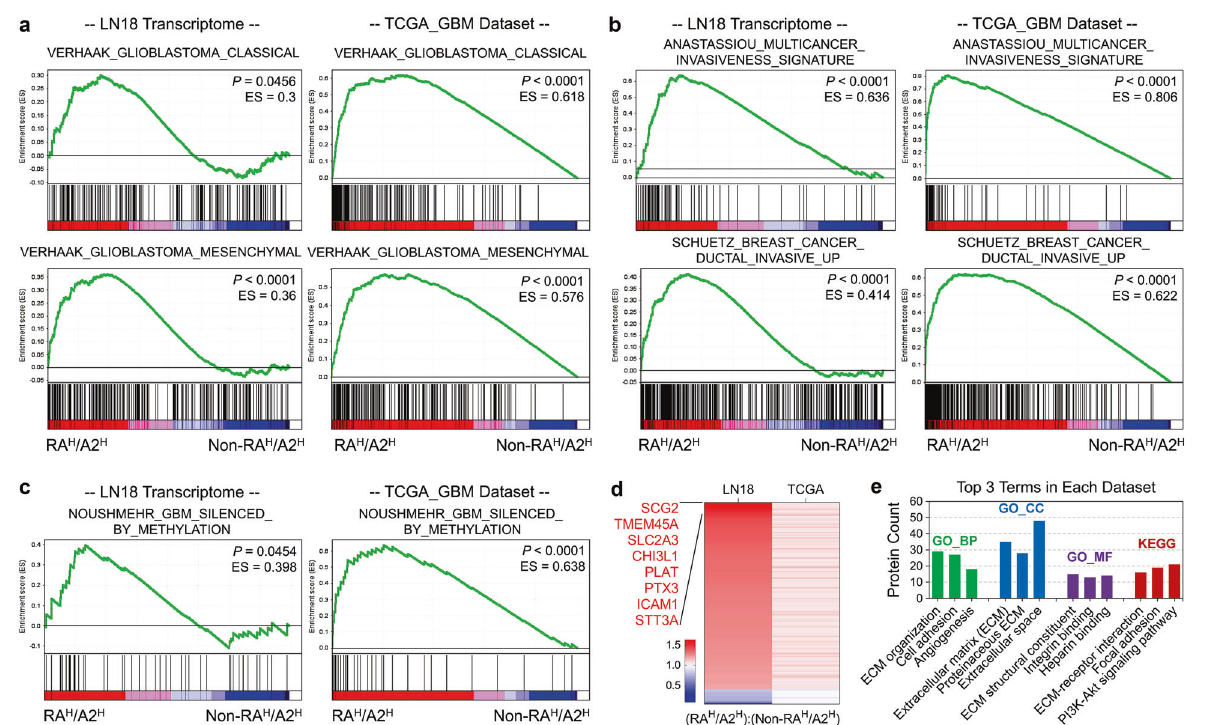
Fig. 4 Transcriptomic analyses on PDGFRA and EPHA2 co-upregulation in GBM cells. a Enrichment of signature genes of GBM molecular subtype for LN18 cells with co-transfection of EPHA2 and PDGFRA (RA H /A2 H ) vs . individual transfection (Non-RA H /A2 H ) (left two panels), as well as, cases with PDGFRA High /EPHA2 High (RA H /A2 H ) vs. all other (Non-RA H /A2 H ) cases from TCGA_GBM mRNA expression dataset (right two panels). b Enrichment of signature genes of invasive growth for LN18 cells with RA H /A2 H vs . Non-RA H /A2 H cases (left two panels), as well as, cases with RA H /A2 H vs. Non-RA H /A2 H from TCGA_GBM mRNA expression dataset (right two panels). c Enrichment of signature genes of GBM G-CIMP subtype for LN18 cells with RA H /A2 H vs. Non-RA H /A2 H (left panel), as well as, cases with RA H /A2 H vs. Non-RA H /A2 H cases